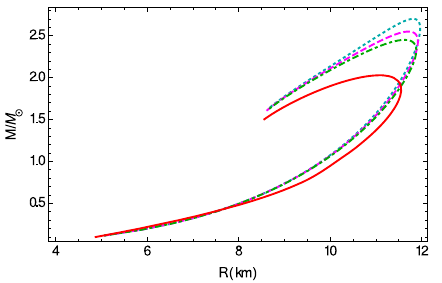
Fig. 20 Variation of ¯ ρ A for three-form quark stars as functions of η , Fig. 21 Variation of the stellar mass M / M (cid:2) as a function of the radius for ¯ a = 0 . 01 and for three different values of the constant ¯ b : ¯ b = 0 of the star R for the three-form field quark stars in the presence of a (dashed curve), ¯ b = − 0 . 11 (dotted curve), and ¯ b = 0 . 11 (dot-dashed Higgs-type potential, for ¯ a = 0 . 01 and three different values of the curve), respectively. The central density of the photon star is ρ mc = constant ¯ b : ¯ b = 0 (dashed curve), ¯ b = − 0 . 11 (dotted curve), and = 7 × 10 − 3 , respectively ¯ b = 0 . 11 (dot-dashed curve), respectively. The solid curve shows the 1 . 28 × 10 15 g / cm 3 , while ¯ ζ 0 = 0 and ¯ ζ (cid:13) 0 mass–radius relation for quark stars in standard general